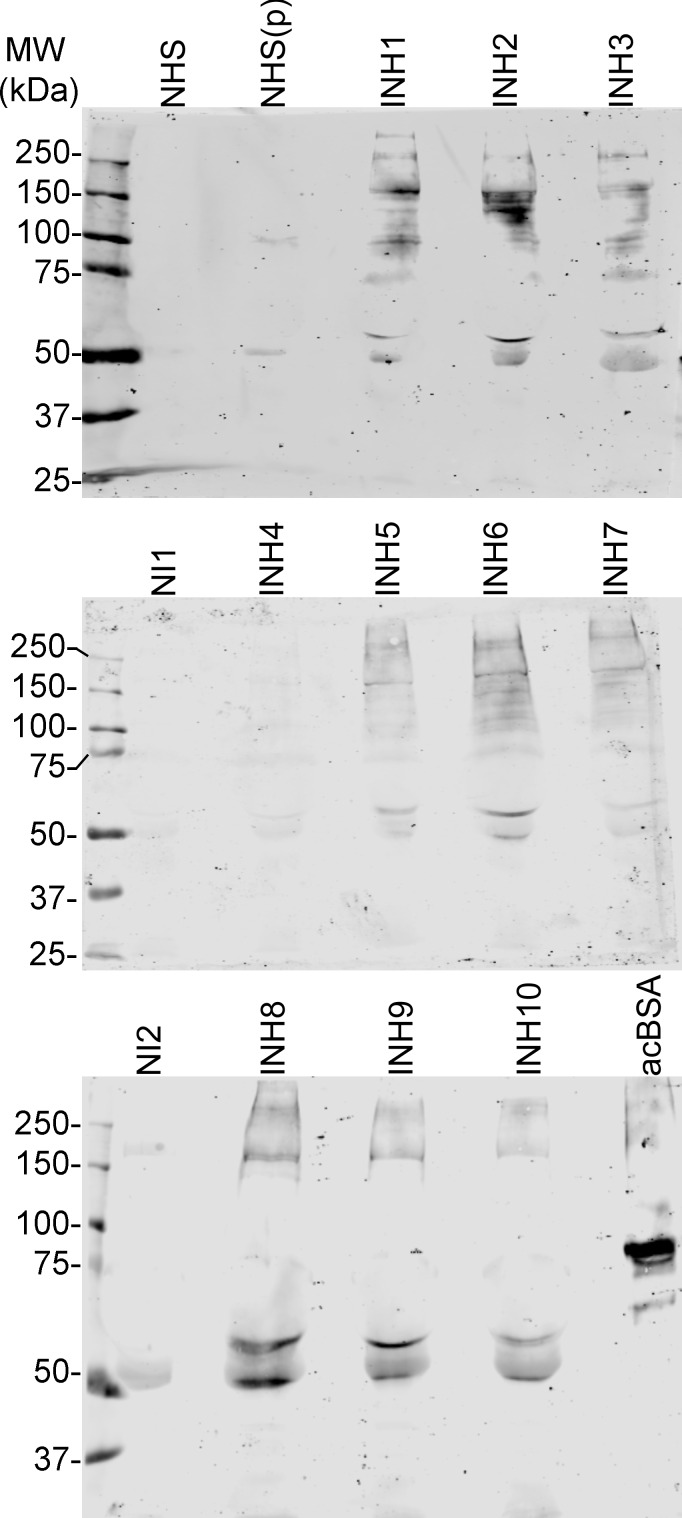
Inhibiting sera have ficolin-2-binding molecules.Normal human serum (NHS), NHS collected in a plastic tube [NHS(p)], noninhibiting archived sera (NI), inhibiting archived sera (INH), and acetylated BSA (acBSA). were assayed for ficolin-2-binding species as described in Materials and Methods. MW, molecular weight.